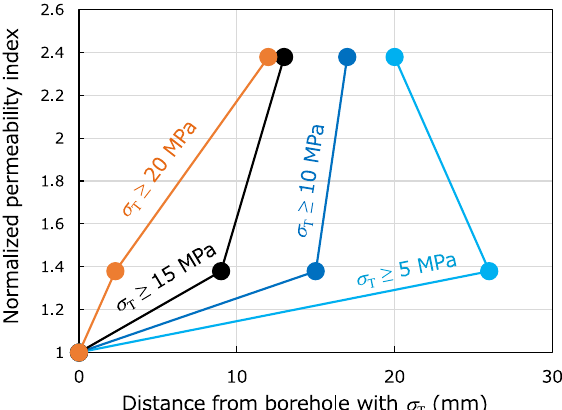
Fig. 11 Relationship between the normalized permeability index and distance from borehole at σ T ( 5, 10, 15 and 20 MPa). The distance where σ T is bigger than σ Tcrit was extracted from the Fig. 10 at each = flow rate. Graph was plotted with the value of permeability index and the distance at each flow rate